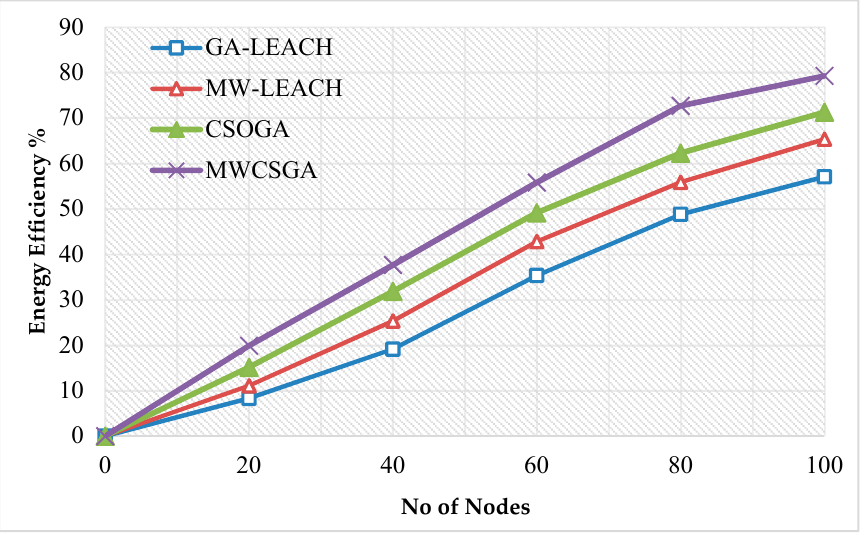
Figure 10. Energy efficiency calculation.